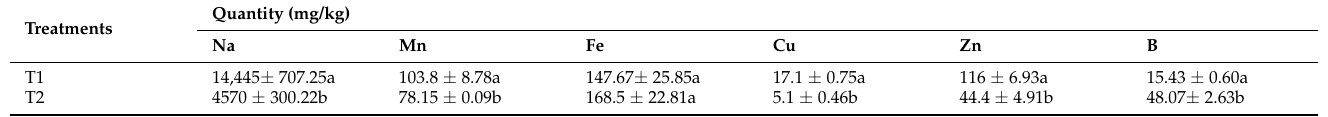
Table 3. Tissue nutrient contents of shoots (mean ± SE) of H. odoratissimum grown in aquaponic and hydroponic systems for six weeks under greenhouse